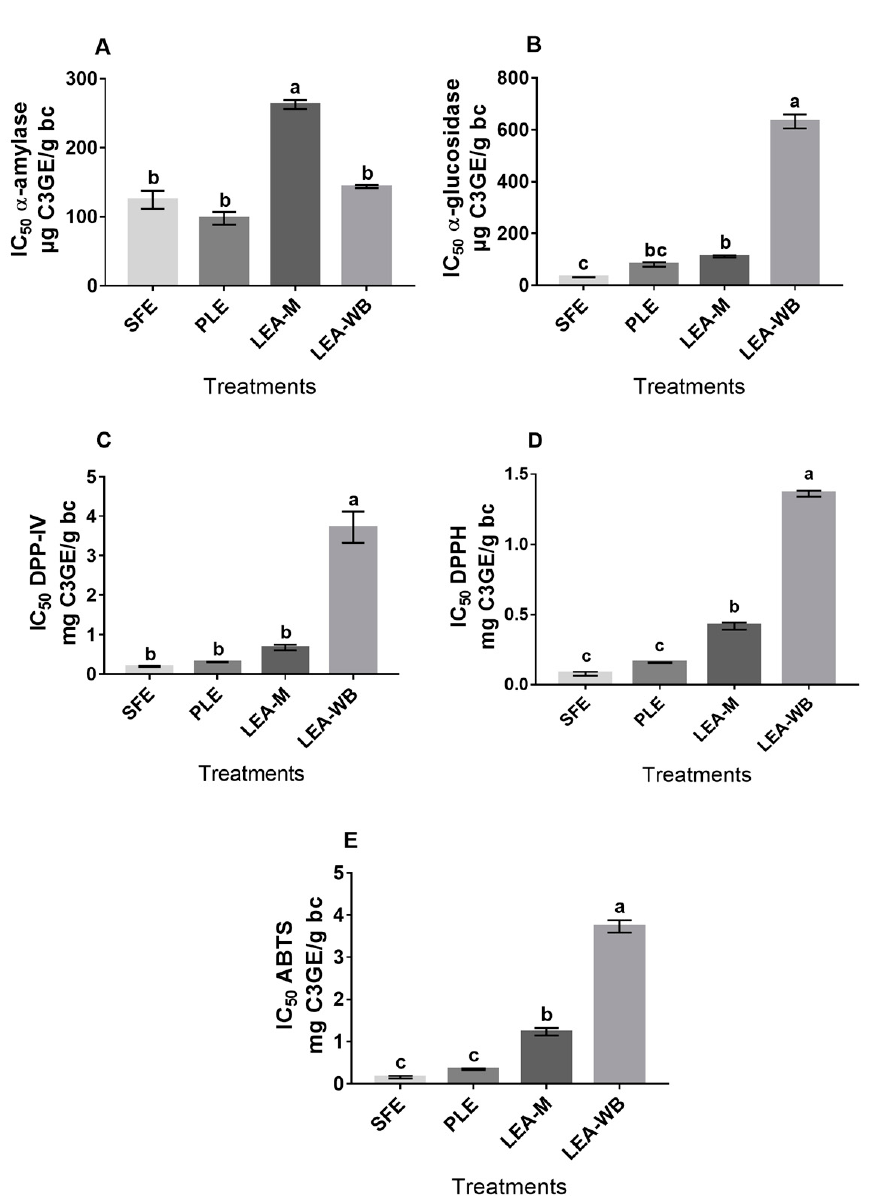
Figure 2. Biological potential of anthocyanin-rich extract from different methods . Half-maximal inhibitory concentration (IC 50 ) of α -amylase ( A ), α -glucosidase ( B ), DPP-IV ( C ), DPPH ( D ) and ABTS ( E ). SFE: Supercritical extraction, PLE: Pressurized liquid extraction, LEA-M: Leaching extraction of manually husked bean coat, LEA-WB: Leaching extraction of whole black bean. C3GE: Cyanidin 3-glucoside equivalents, bc: Bean coat. The results are shown as mean ± standard error. Different letters indicate significant differences among samples at p < 0.05 (Tukey’s HSD post hoc analysis).